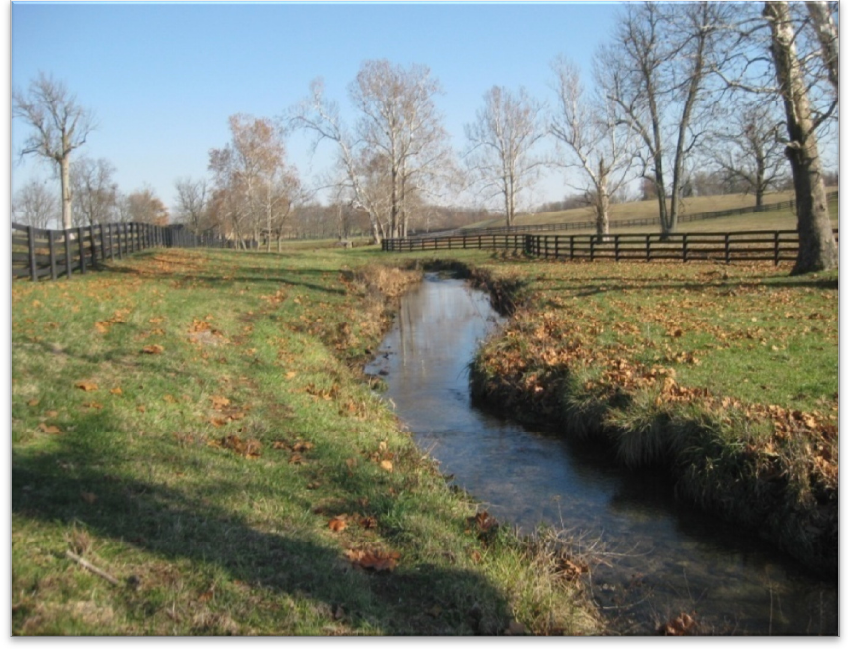
Figure 3. Example of grass-dominated riparian vegetation at Cave Creek near Fort Springs (03288500) in the Inner Bluegrass